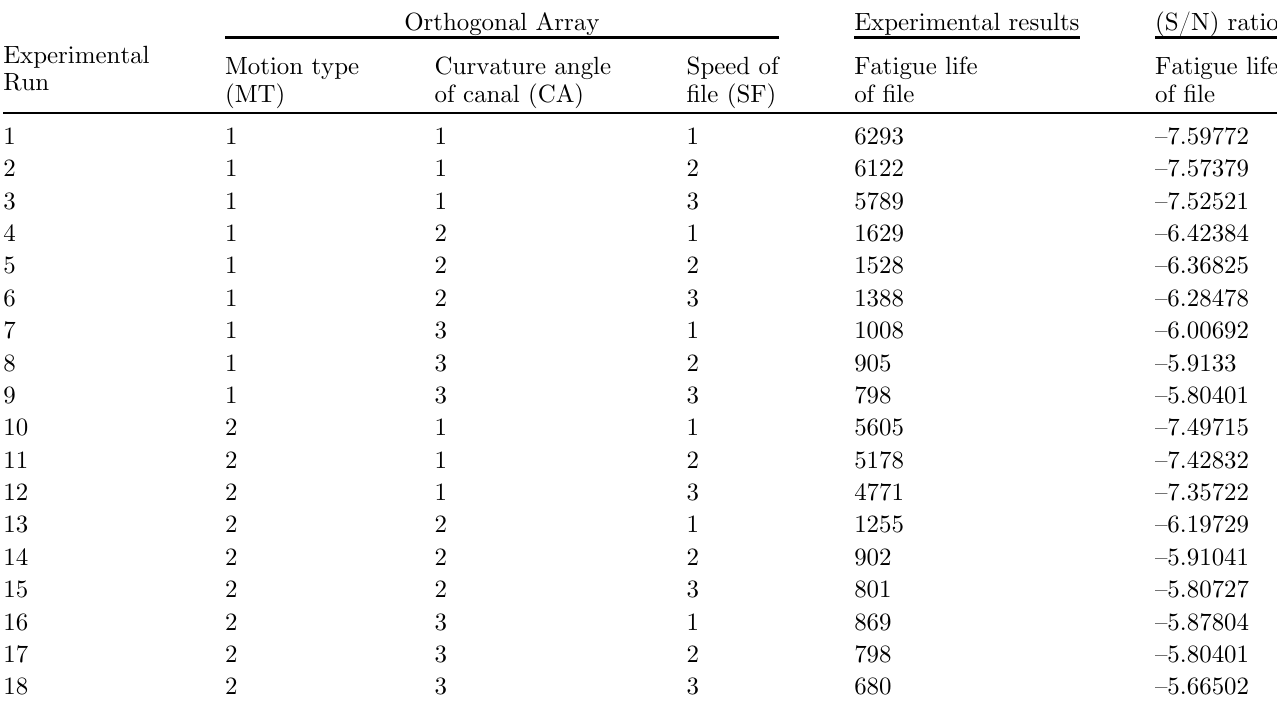
Table 7. Experimental design using L-18 orthogonal array. Experimental